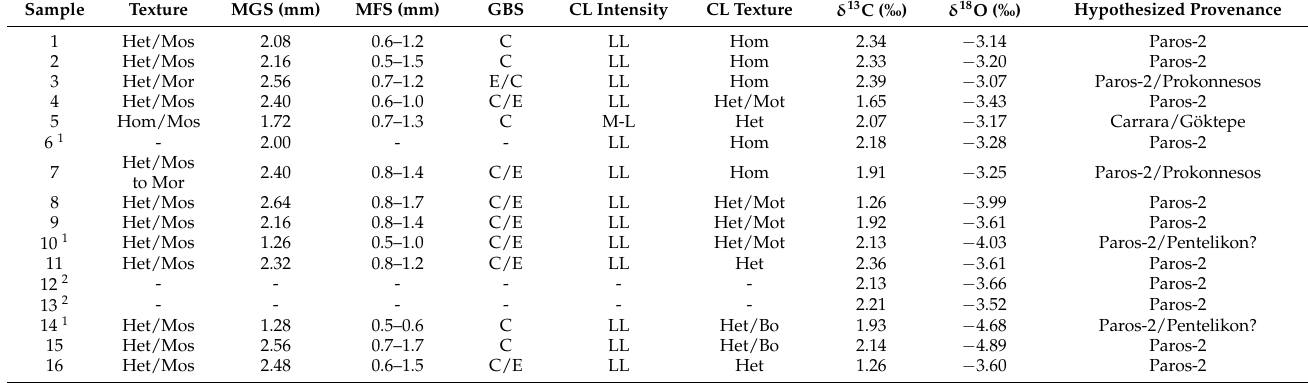
Table 2. List of the main petrographic characteristics and isotopic ratios (V-PDB ‰) correspond- ing to the measured samples. Textural qualifiers are Hom: homogeneous; Het = heterogeneous; Mor = mortar; Mot = mottled; Bo = boundary grains; MGS is maximum grain size; MFS is most frequent grain size range. GBS is grain boundary shape, C = curved or E = embayed. CL is cathodolu- minescence; LL (very low)/L (low)/M